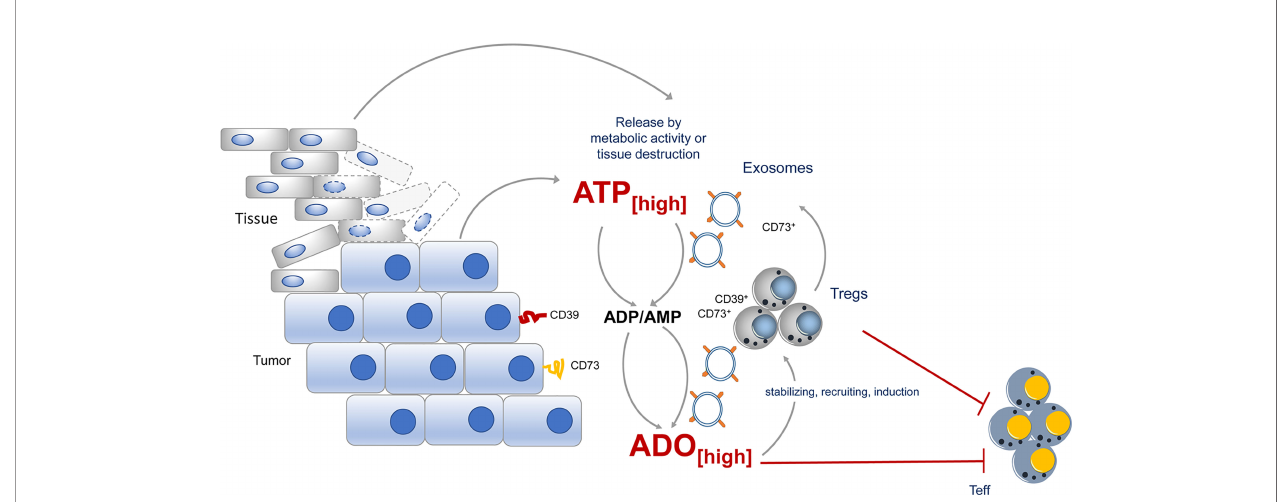
FIGURE 2 | CD73 expression during tumor growth contributes to immune suppression. During tumor growth ATP is either actively release by metabolic active tumors or by dying tissue cells. ATP will quickly be degraded into immunosuppressive adenosine by CD73 expressed by the tumor itself, by incoming Tregs or by exosomes, derived from the tumor or tumor in fi ltrating lymphocytes. Adenosine maintains the suppressive activity of Tregs in the tumor vicinity and altogether an immunosuppressive environment is